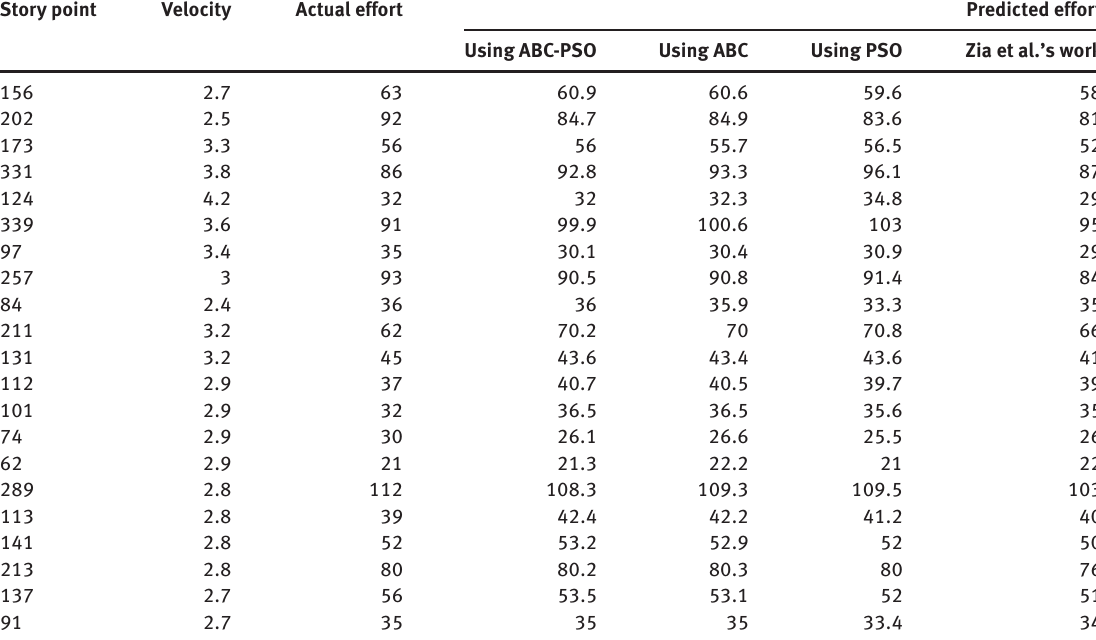
Table 5: Experimental Results. Story